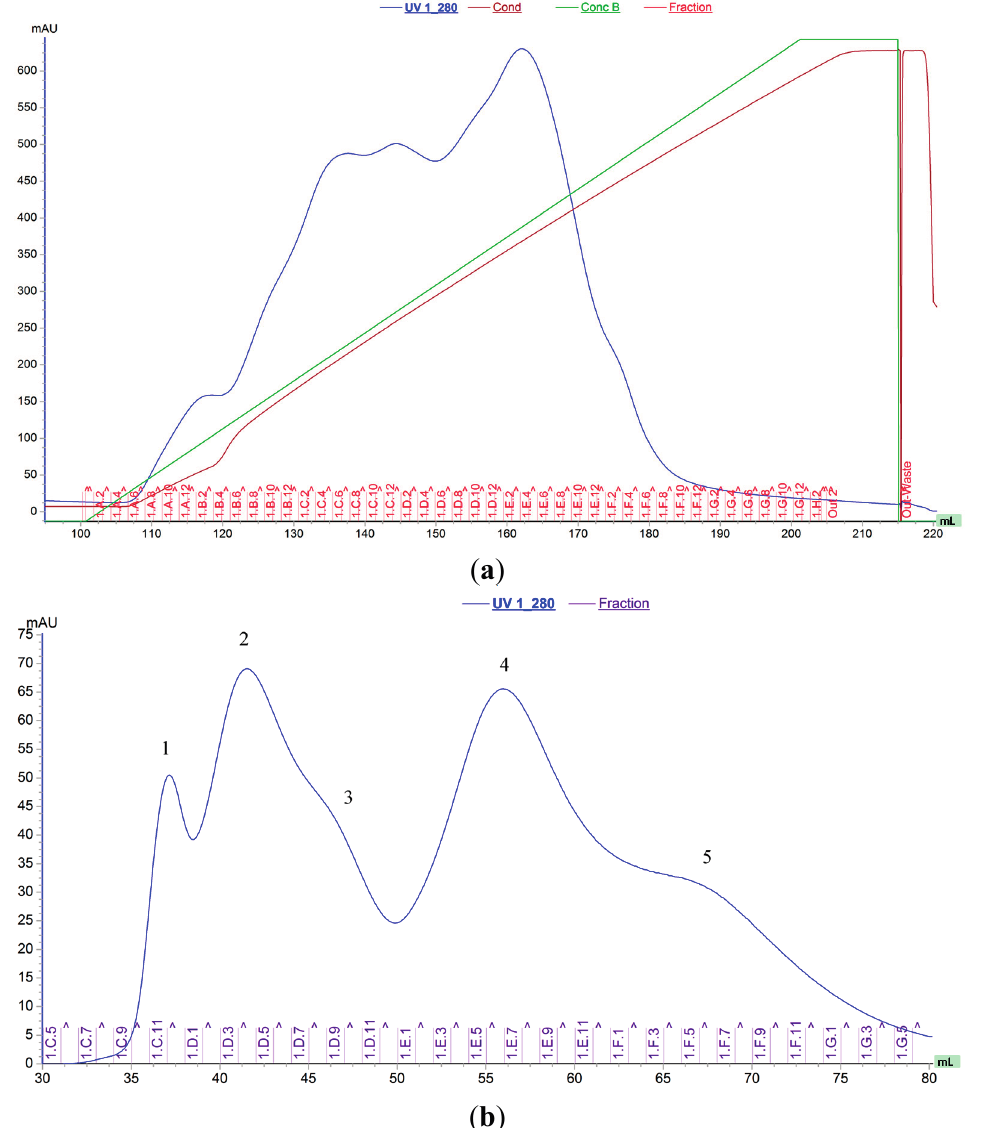
Figure 1. Anion-exchange and gel filtration chromatograms of the E. carinicauda chitinases. ( a ) Anion-exchange chromatography on HiTrap Q FF 5 mL. Fractions (1C2 to 1D6) with chitinolytic activity were collected for next process; ( b ) Gel filtration on HiPrep16/60 Sephacryl S-100. Five proteins were purified, chitinolytic activity was detected in peak 4 and 3, and they were named as EcChi1 and EcChi2,